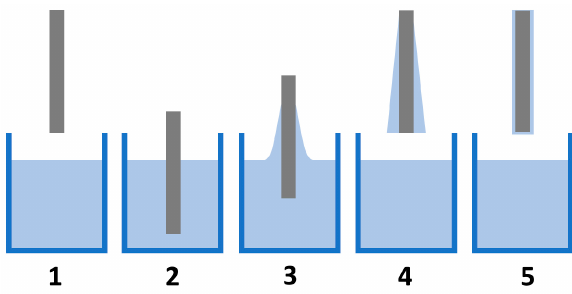
Figure 10. The five steps of the dip-coating process .